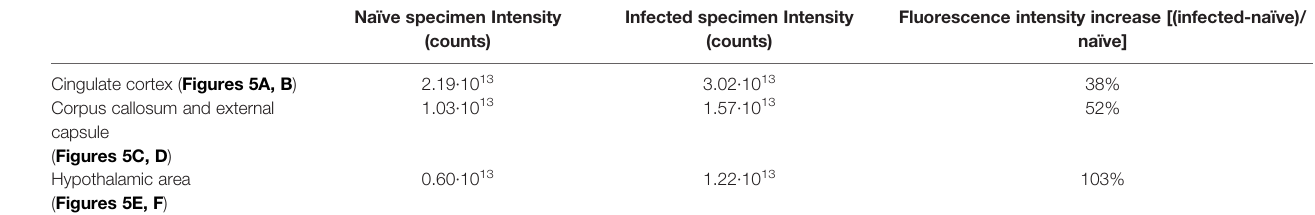
TABLE 1 | Fluorescence intensity values for the region of the specimen shown in Figure 5